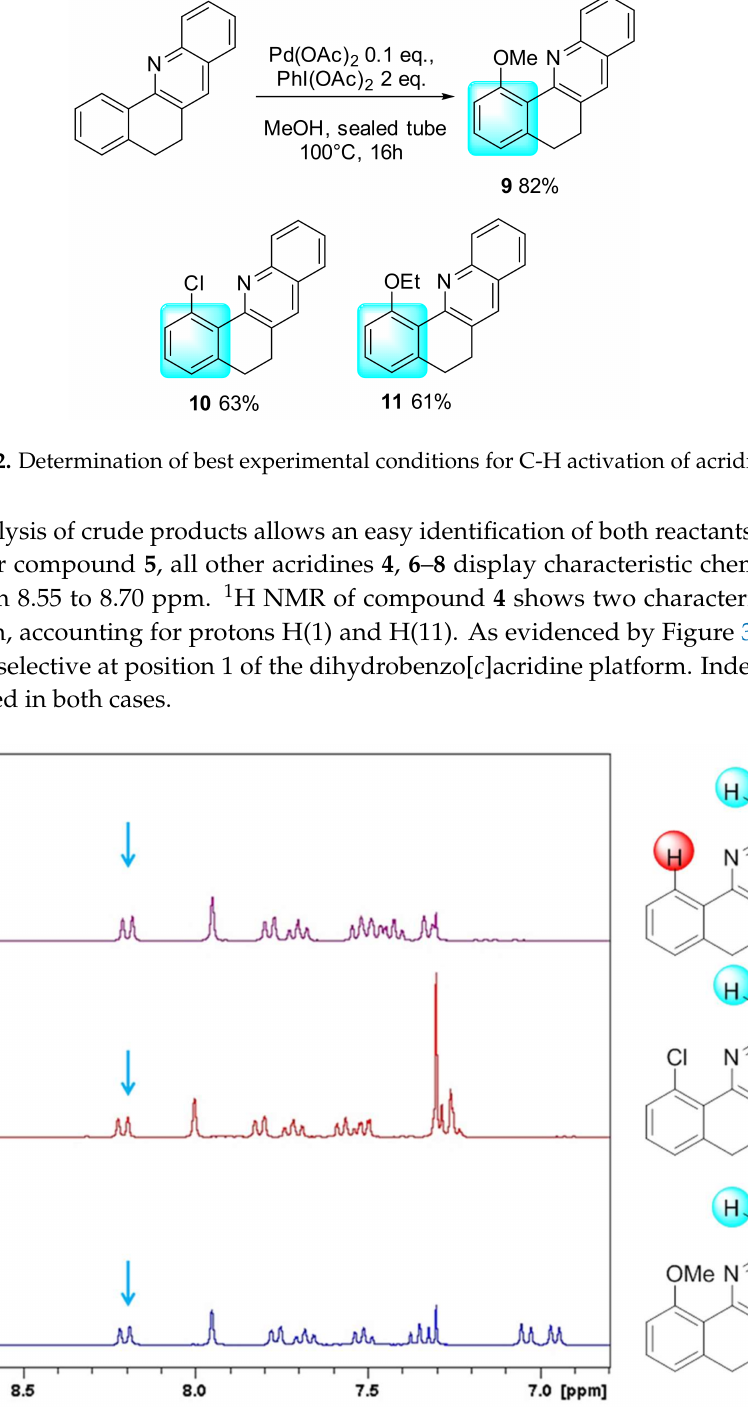
Figure 3. 1 H NMR characteristic signals for H(1) –red arrow and H(11) – blue arrow acridine derivatives 4 , 9 , and 10